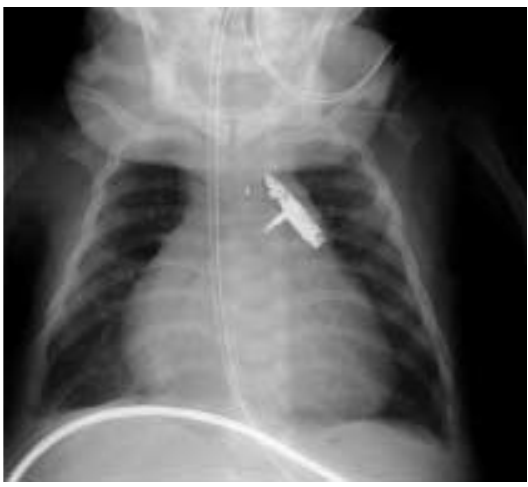
Postoperative chest X-ray showing the FloWatch™ im- planted around the pulmonary